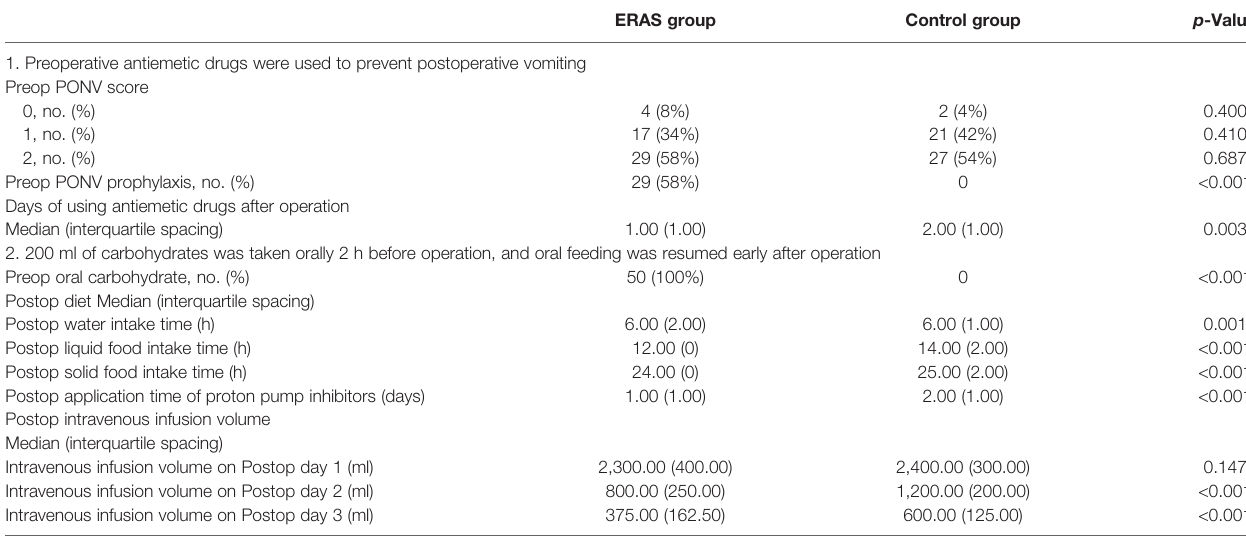
TABLE 3 | The fi rst part of ERAS measures and effects.